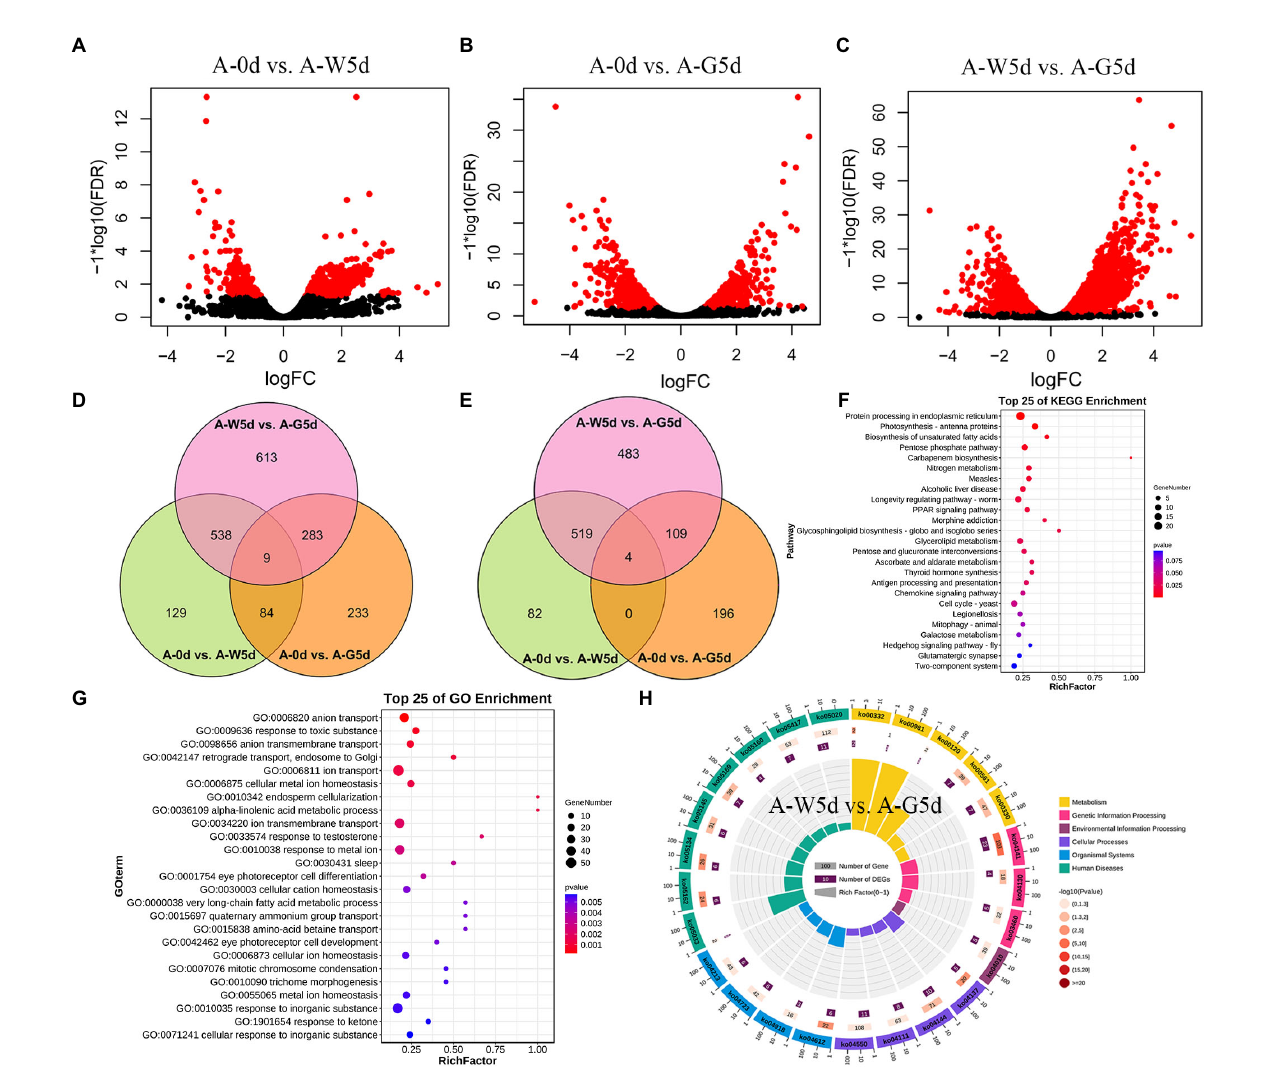
FIGURE 4 Differential expression and functional enrichment analysis of RNA-seq data. (A) Volcano plot of DEGs in A-0d vs. A-W5d. (B) Volcano plot of DEGs in A-0d vs. A-G5d. (C) Volcano plot of DEGs in A-W5d vs. A-G5d. Blue circles represent up- or downregulated DEGs. (D) Venn diagram of all DEGs in A-0d vs. A-W5d, A-0d vs. A-G5d, and A-W5d vs. A-G5d. (E) Venn diagram of up regulated DEGs in A-0d vs. A-W5d, A-0d vs. A-G5d, and A-W5d vs. A-G5d. (F) Top 25 KEGG enrichment pathways for DEGs in A-0d vs. A-W5d. (G) Top 25 GO enrichment pathways for DEGs in A-0d vs. A-G5d. (H) KEGG enrichment pathway for DEGs in A-W5d vs.